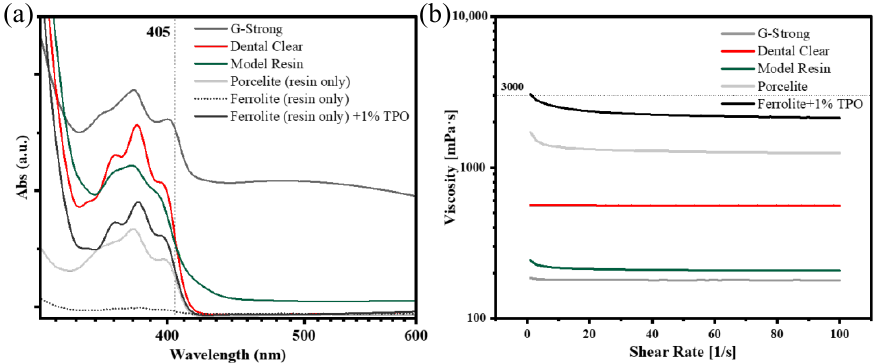
Figure 3. Characterization of photopolymers: ( a ) UV-Vis absorption and ( b ) rheology of the photopolymers and suspensions. Dashed lines in ( a , b ) correspond to the wavelength of the DLP source and reported limit of viscosity for self-recoating of liquid photopolymer, respectively.